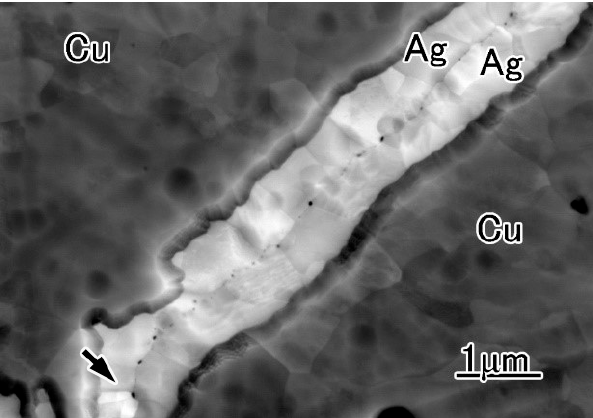
Figure 12. Enlarged image of the interface between wires. The arrow indicates a small pore at the interface.